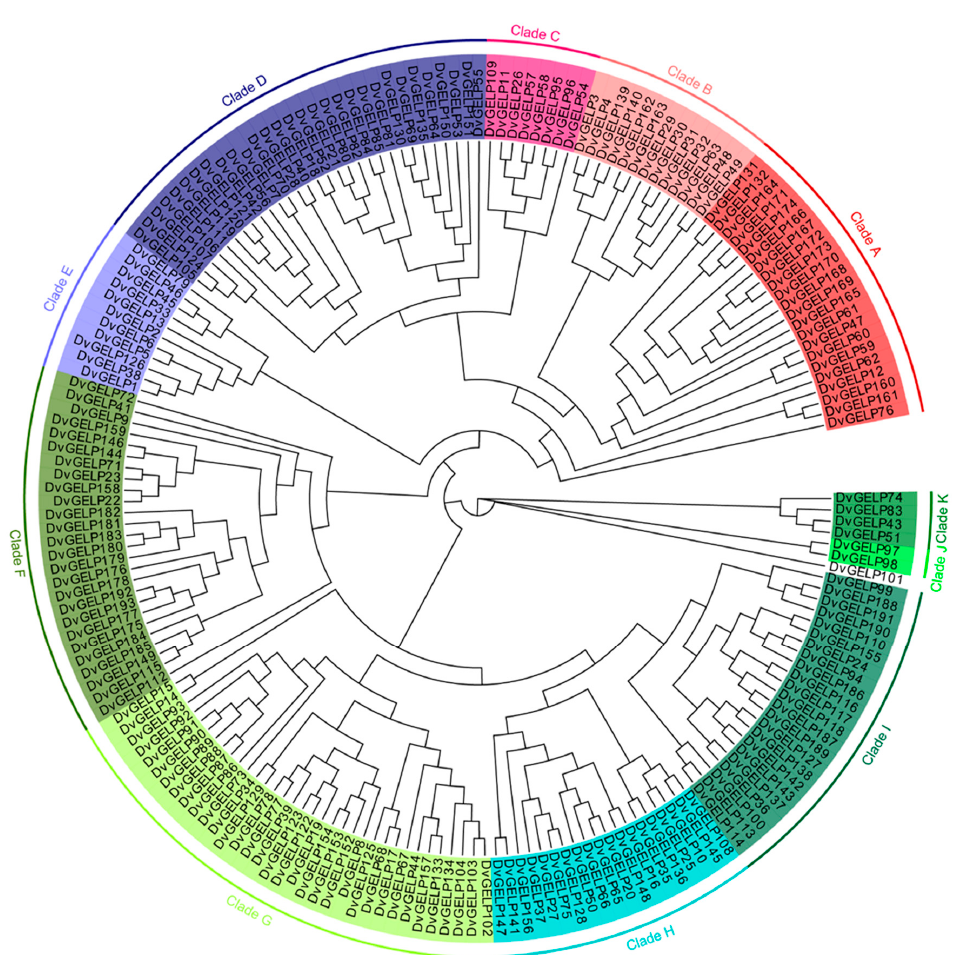
Figure 1. The phylogenetic tree of the GELP gene family from D. villosum.